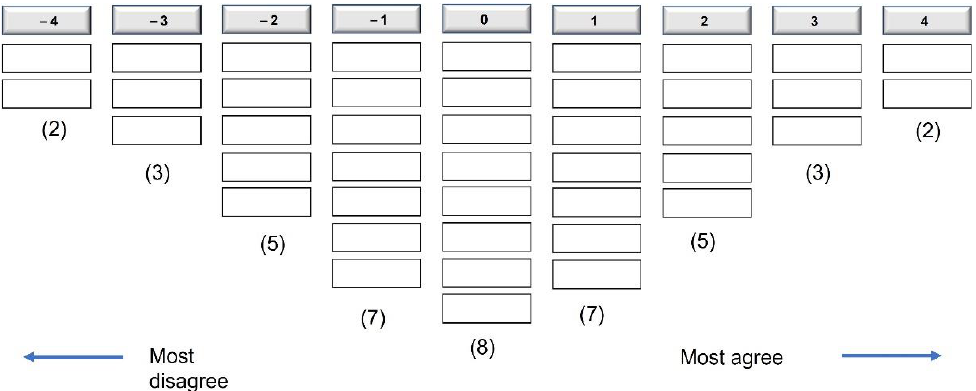
Figure 6. Bell-shaped distribution used for Q sorting.